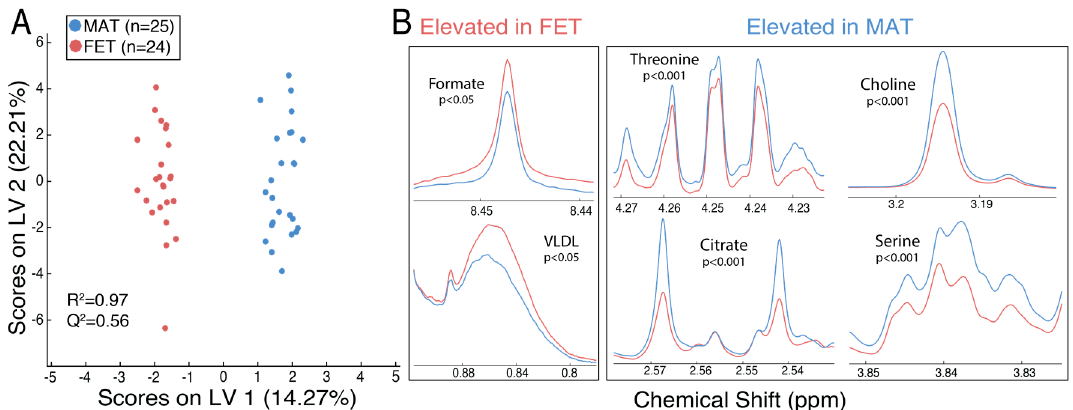
Figure 2. ( A ) Orthogonal signal correction–partial least squares discriminant analysis (OSC–PLSDA) scores plot reveals a separation of MAT (blue, n = 25) and FET (red, n = 24) spectra from 13 placentas at 15 min postdelivery; ( B ) the mean spectra of FET (red) and MAT (blue) display significant (FDR-corrected p < 0.05) elevations in formate and VLDL in fetal placental specimens (left), while threonine, choline, citrate, and serine are significantly elevated in the maternal tissue (right). Table 1 displays the means with standard errors, FDR-corrected p-value, and fold change for all metabolites identified. Table 1. Metabolites identified on maternal and fetal surfaces of the placenta at 15 min postdelivery.